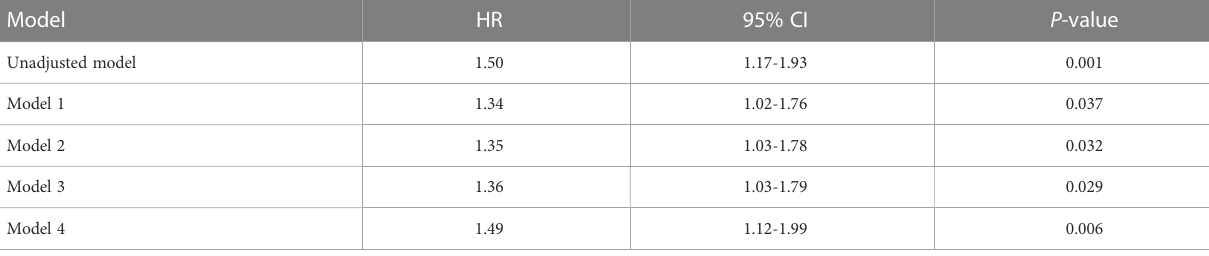
TABLE 2 HR (95% CI) for risk of ESRD according to the TyG index at baseline. Model